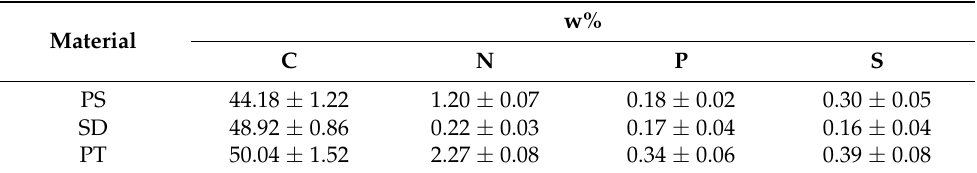
Table 3. Content of C, N, P, and S elements in different materials.